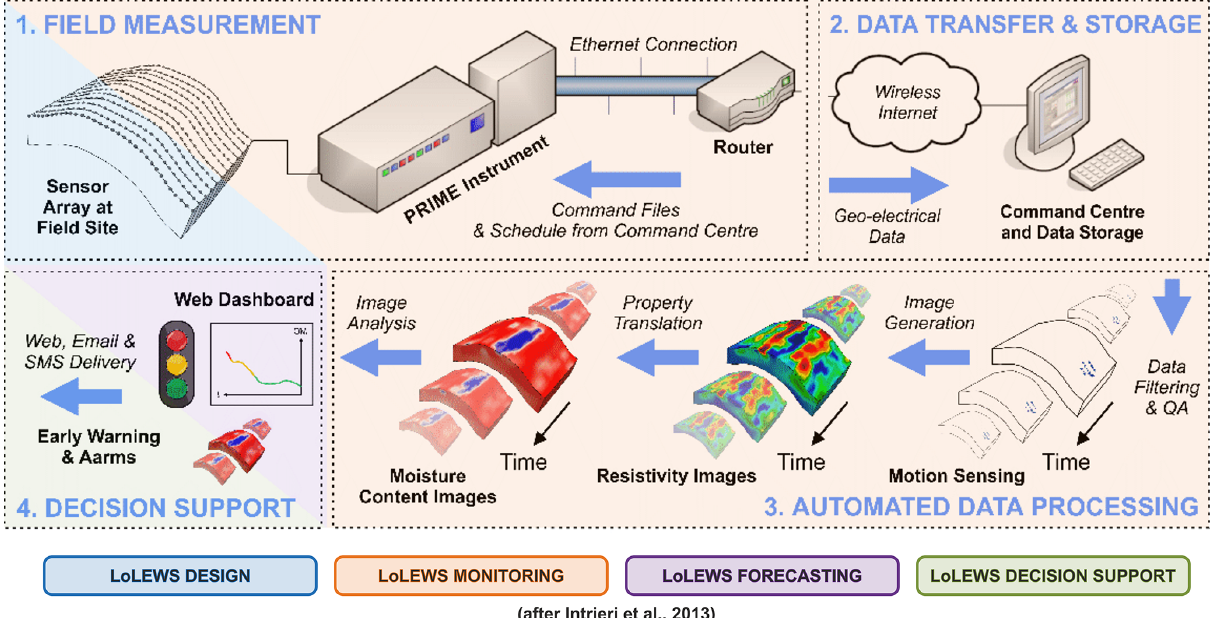
Figure 2. The PRIME system workflow for handling resistivity-monitoring data and demonstrating the acquisition, transmission, filtering, processing, translation and dissemination of geophysical models for slope failure early warning; the components of establishing LoLEWS are colour-coded at each stage (after Intrieri et al., 2013). Modified from Holmes et al.